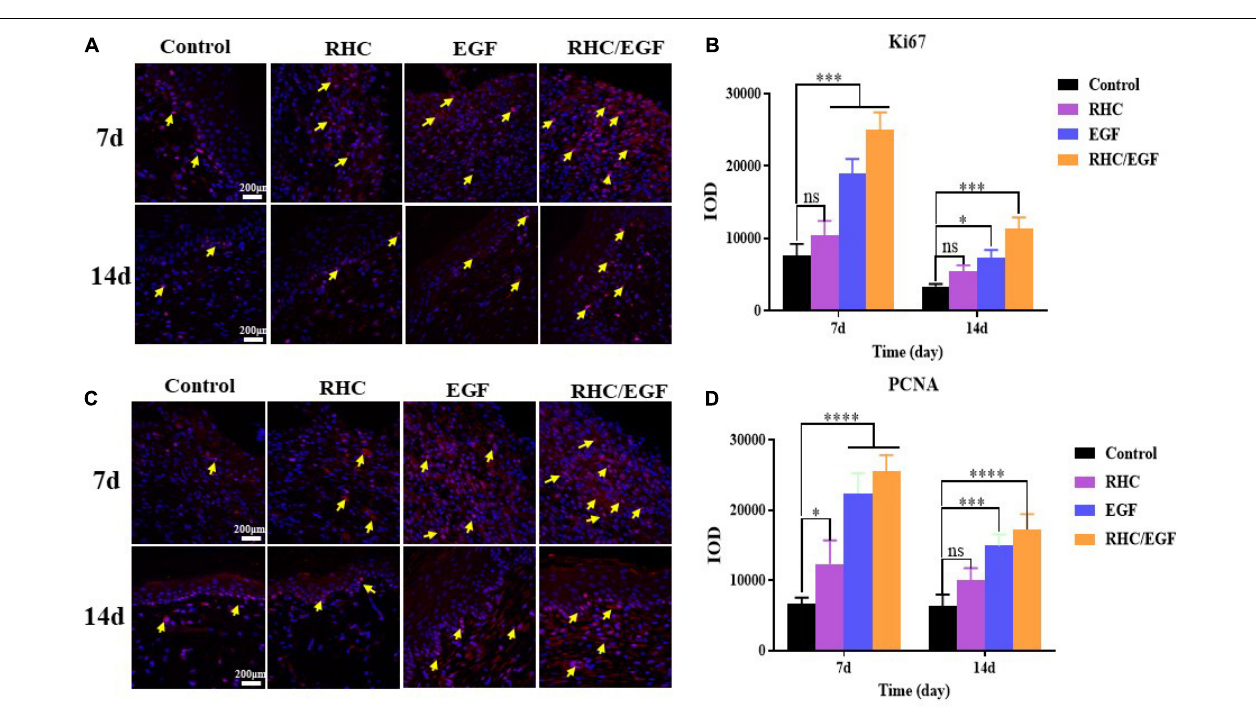
FIGURE 5 | Immunofluorescence examination of Ki-67 and PCNA expression. (A) Immunofluorescence examination of Ki-67–positive cells after treatment for 7 and 14 days. Arrows indicate Ki-67 expression. (B) Quantitative analysis of Ki-67–expressing cells at 7 and 14 days measured using ImageJ software. (C) Immunofluorescence examination of PCNA-positive cells after treatment for 7 and 14 days. Arrows indicate PCNA expression. (D) Quantitative analysis of PCNA-expressing cells at 7 and 14 days measured using ImageJ software. n = 3, means ± SD, ∗ P < 0.05, ∗∗∗ P < 0.001, ∗∗∗∗ P < 0.0001 vs. control group, ns means no significant difference vs. control group, P >